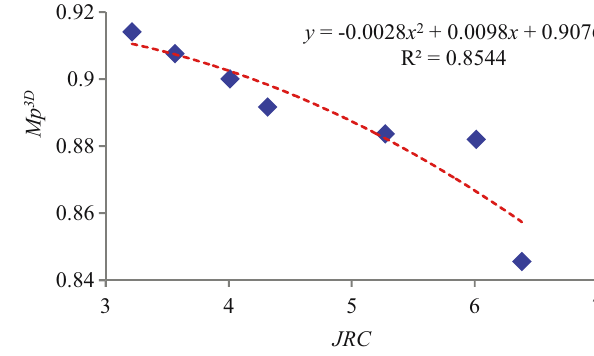
Figure 13: Relation curve of M p3D − JRC.